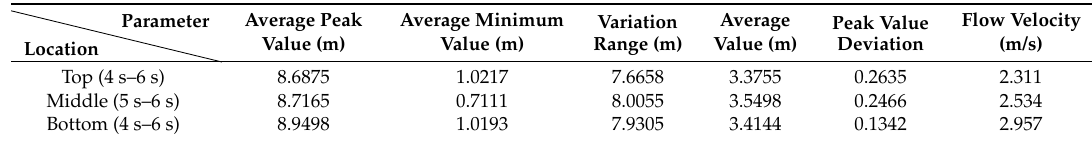
Table 4. Flushing results by setting round nozzle at different locations.